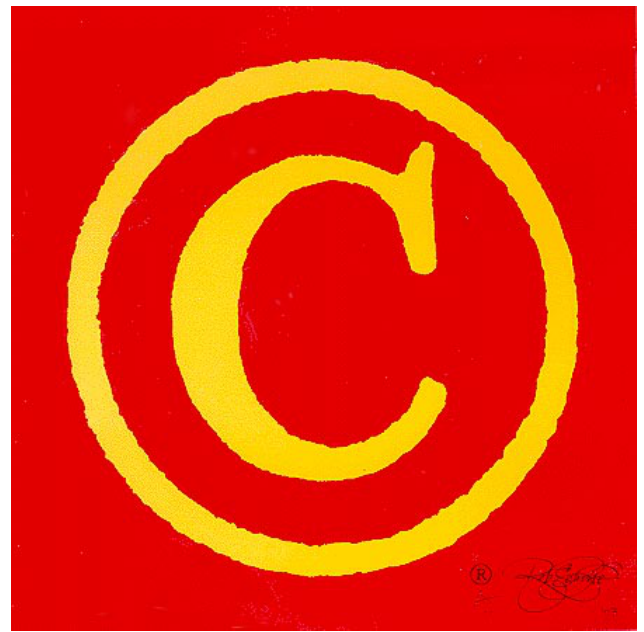
Figure 1: Rob Scholte, Self